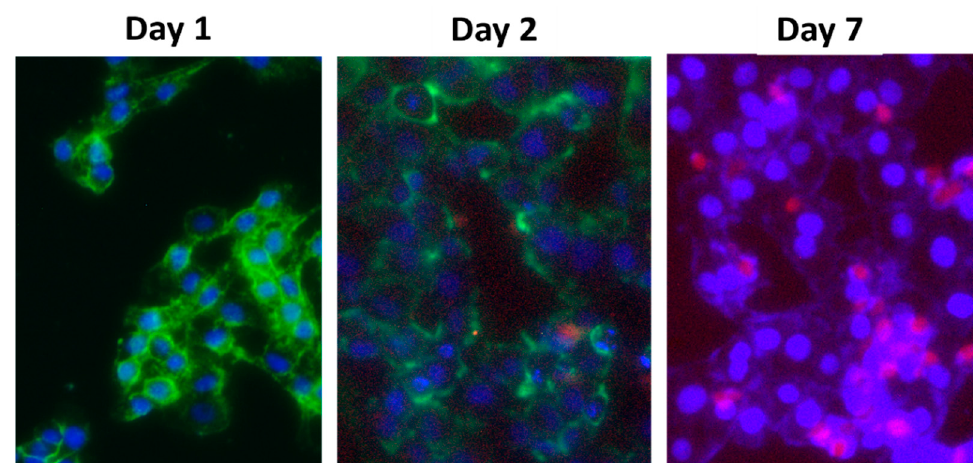
Figure 11. Live cell imaged of HepG2 to visualize their RFP expression 24, 48, and 168 h after transfection of CRISPR plasmids encapsulated into coumarin-6 labeled ALG NPs. Blue is nuclei, red is expressed Cas9-RFP in cytosol, and green is the nanoparticles labeled with coumarin-6. Almost all cells were transfected with the particles, and the majority of particles were localized in cytosol. No expressing of RFP on day 1. On the other hand, the quantity of nanoparticles decreased as it probably degraded or disintegrated and released the plasmid hence the cells start to express Cas9-RFP. Lastly, on day 7, most cells were expressing Cas9-RFP, and almost the cytosol of all cell is absent from the nanoparticles.